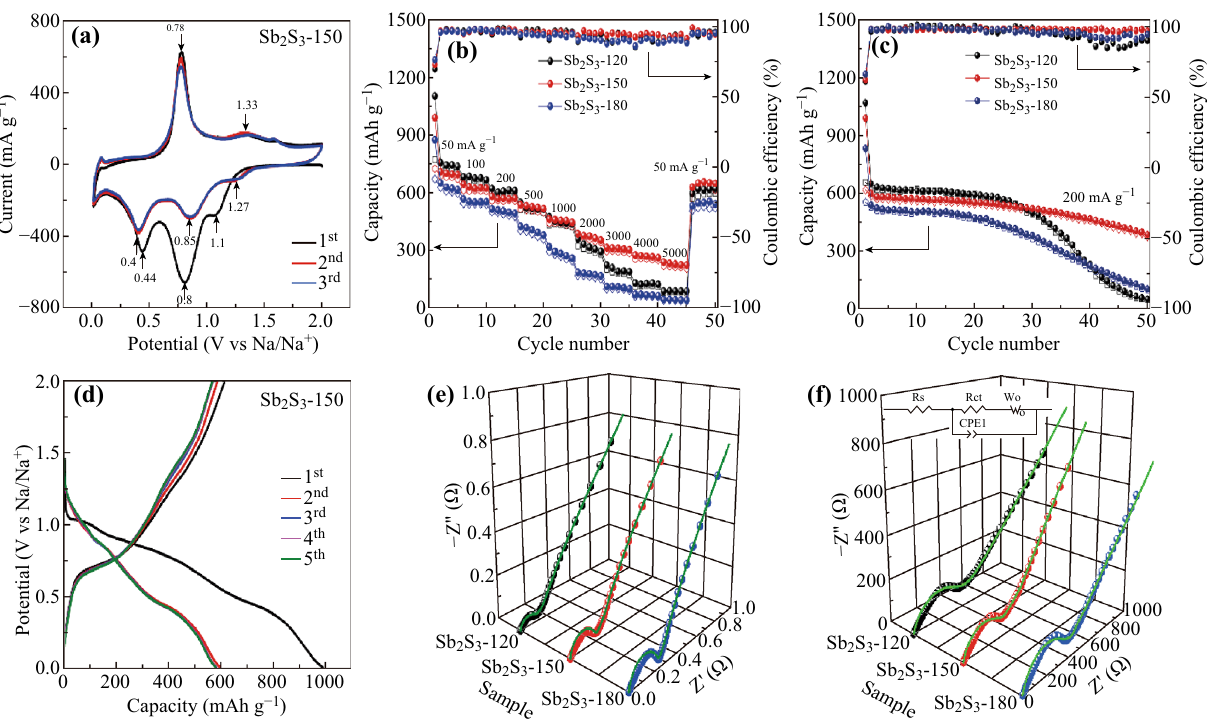
Fig. 5 Excellent sodium-storage performance of as-prepared Sb 2 S 3 electrodes. a CV curves of Sb 2 S 3 -150 in first three cycles with a scan rate of 0.1 mV s - 1 . b Rate capability of the Sb 2 S 3 -120, Sb 2 S 3 -150 and Sb 2 S 3 -180 at various current densities (increased from 50 to 5000 mA g - 1 ). c Cycle performance of the Sb 2 S 3 -120, Sb 2 S 3 -150 and Sb 2 S 3 -180 electrodes at a current density of 200 mA g - 1 . d Charge/discharge voltage profiles of